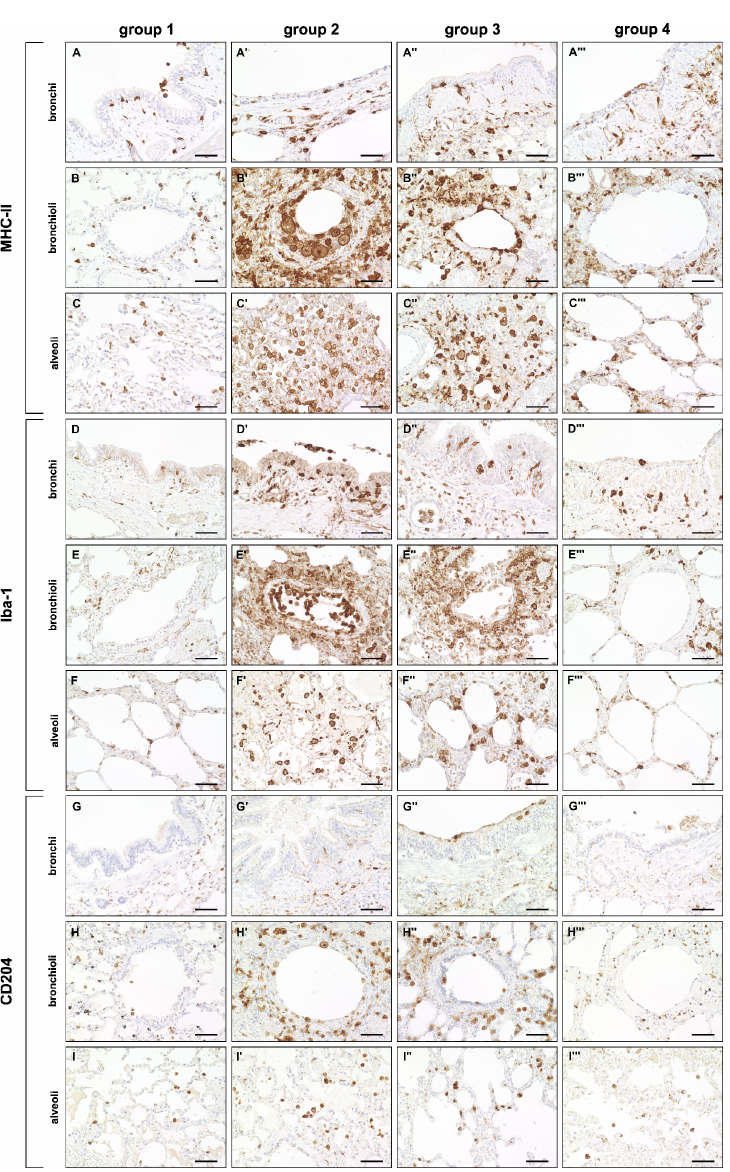
Figure 3. Innate cellular immune responses in canine distemper virus (CDV)-infected lungs. ( A – C”’ ) Major histocompatibility complex (MHC)-II + cells (antigen-presenting cells) in the bronchial ( A – A”’ ), bronchiolar ( B – B”’ ) and alveolar region ( C – C”’ ). ( D – F”’ ) Ionized calcium–binding adapter molecule 1 (Iba-1) + cells (macrophages) in the bronchial ( D – D”’ ), bronchiolar ( E – E”’ ) and alveolar region ( F – F”’ ). ( G – I”’ ) CD204 + cells (macrophages) in the bronchial ( G – G”’ ), bronchiolar ( H – H”’ ) and alveolar region ( I – I”’ ). Note increased numbers of MHC-II + cells, Iba-1 + cells and CD204 + cells in all anatomical compartments mainly in groups 2 and 3. Groups: 1 = non– infected control lungs; 2 = acute CDV infection; 3 = subacute CDV infection; 4 = subacute-chronic CDV infection. Scale bars: 50 µ